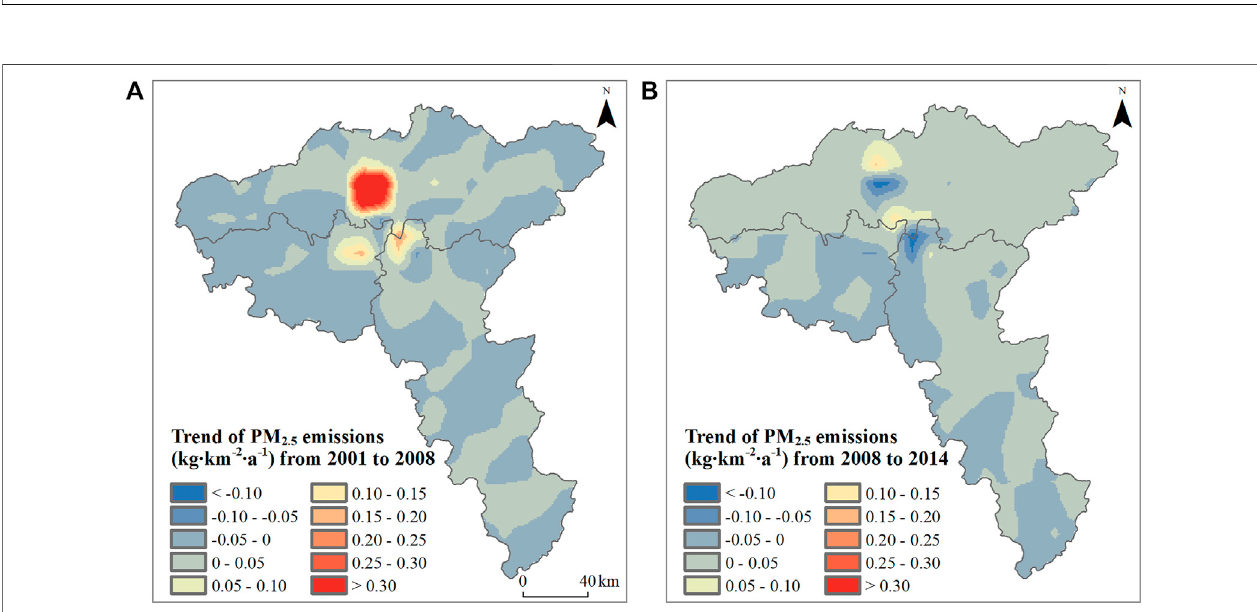
FIGURE 4 | Spatial pattern of the trends in anthropogenic PM 2.5 emissions during (A) 2001 – 2008 and (B) 2008 – 2014.